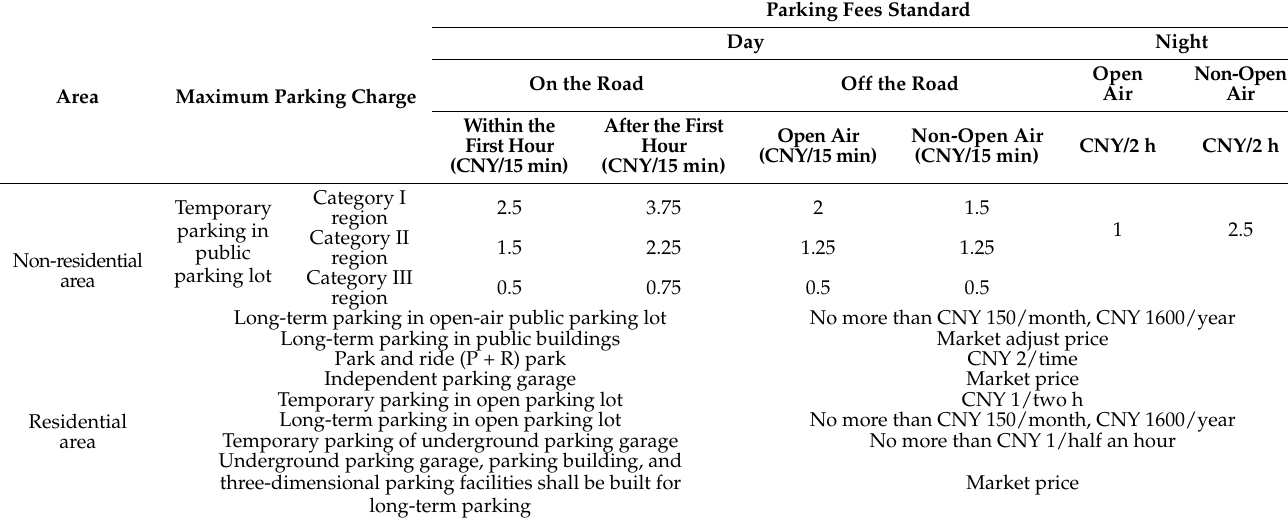
Table 2. Strategy of parking charge in Beijing.